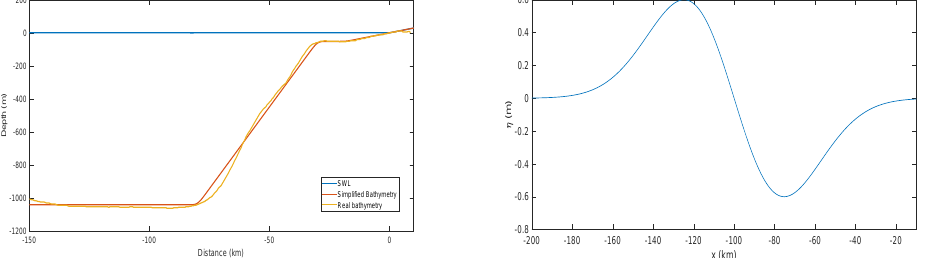
Figure 12. Cross-section of the bathymetry of Aceh (left) and initial wave (right)